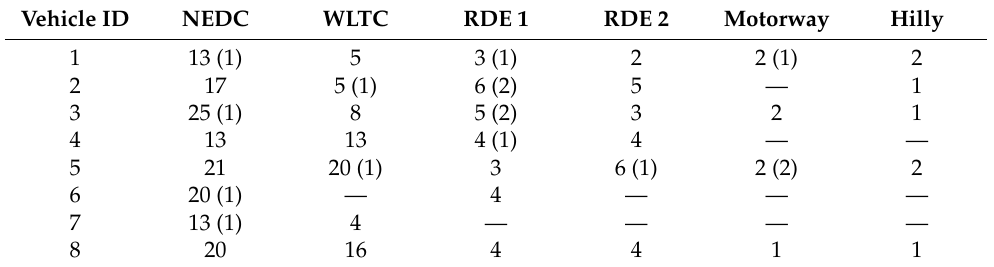
Table A2. Total number of tests and tests with DPF regeneration (in parenthesis) for each vehicle.